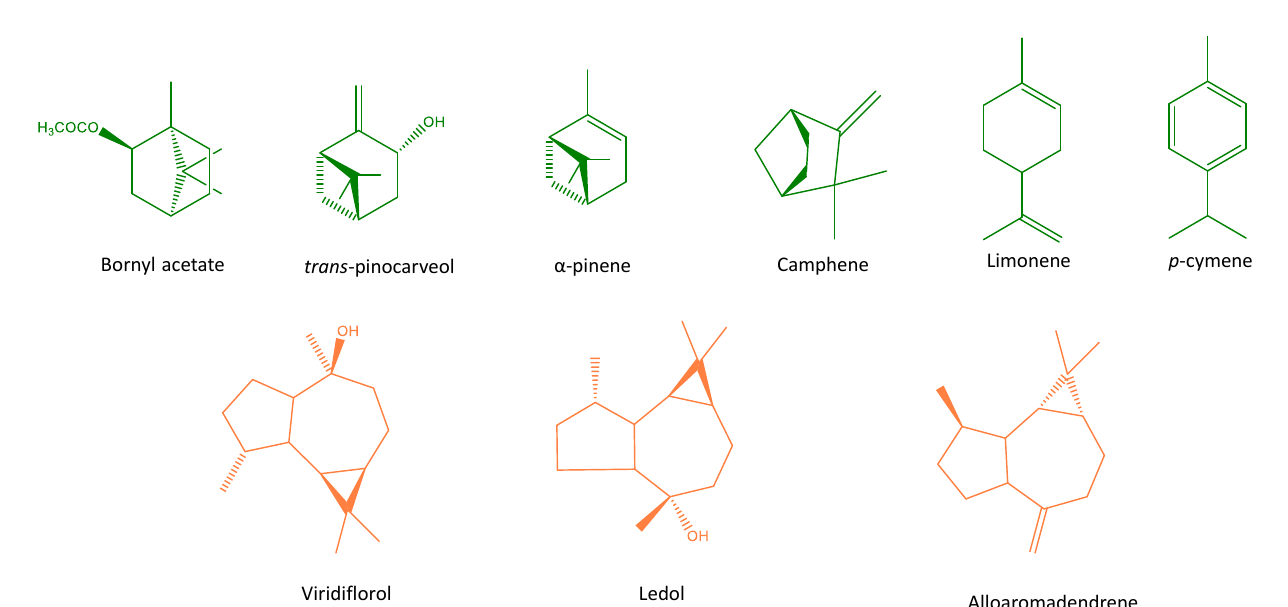
Figure 3. Main compounds of essential oils obtained from stored Cistus